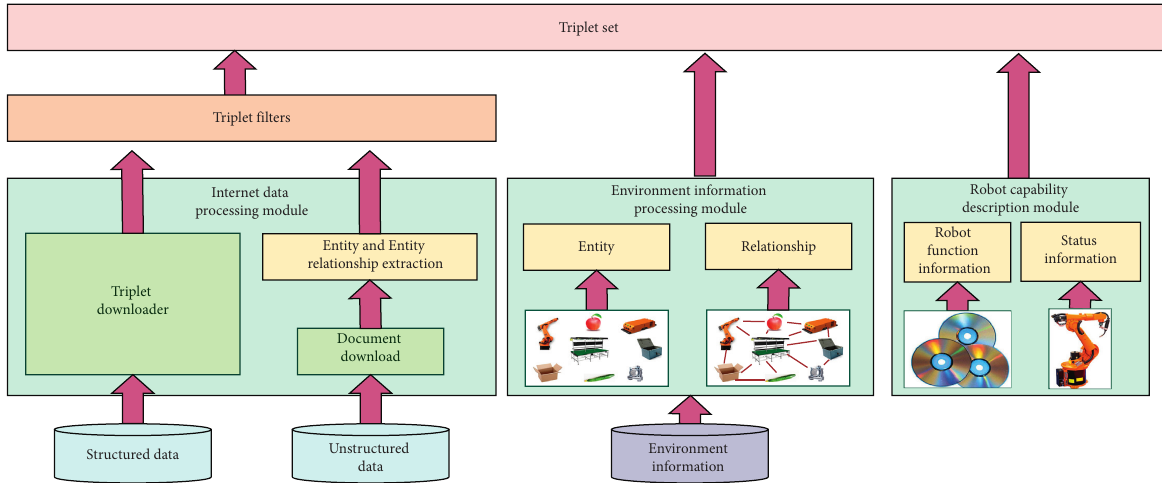
Figure 2: Logical structure of knowledge